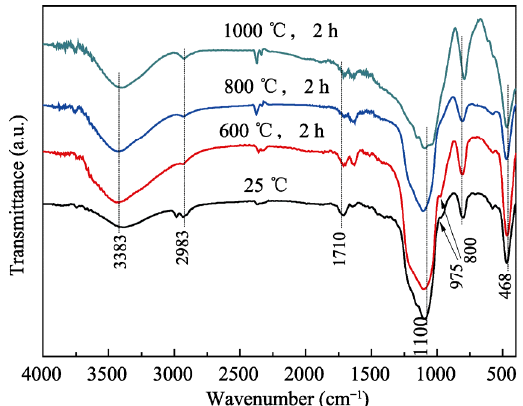
Fig. 1 FTIR spectra of SiO 2 aerogels treated at different temperatures.